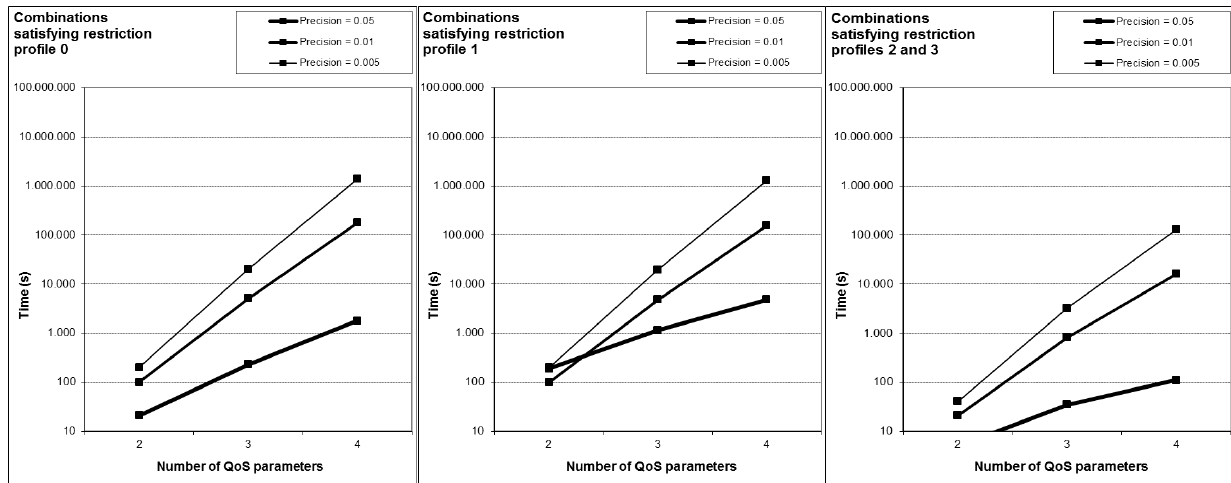
Figure 7. Experimental results: Combinations as solutions, for each profile and precision.